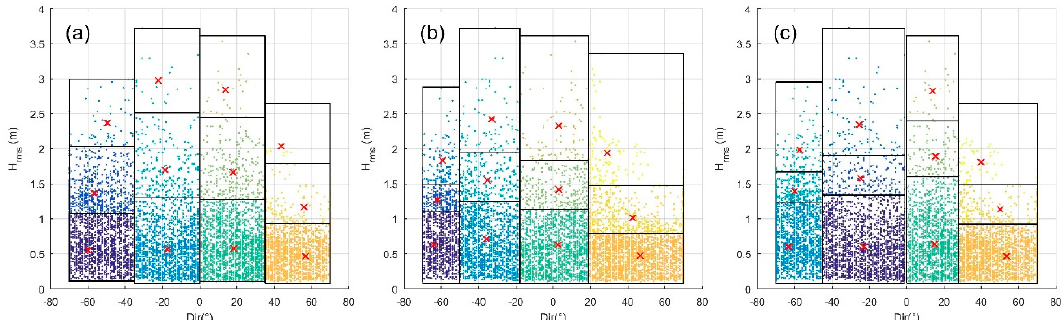
Figure 3. Examples of a selection of Fixed Bins ( a ), Energy Flux ( b ), and Sediment Transport Bins ( c ) methods with 12 representative wave conditions. The red crosses are the representative wave conditions, and the small dots are the wave data. The colors and black lines indicate the bins.